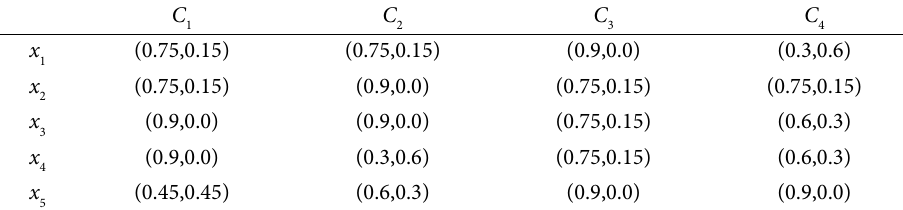
Table 2. Intuitionistic fuzzy decision matrix